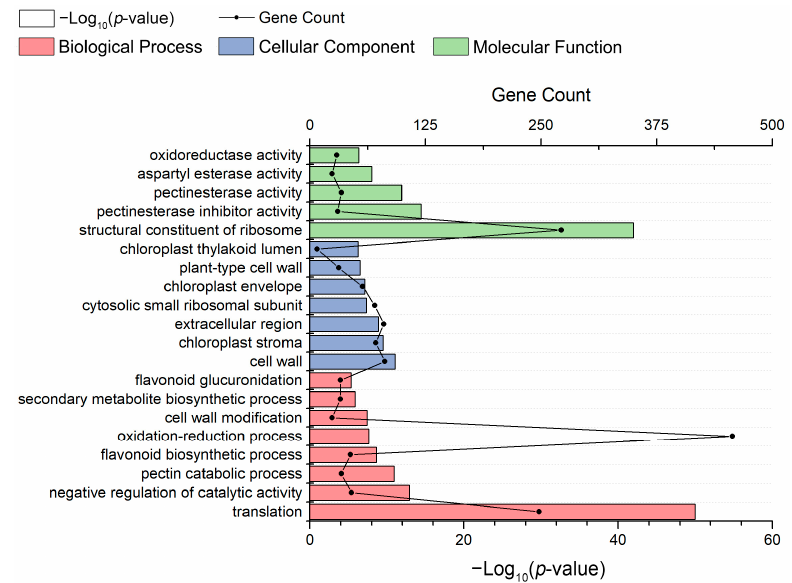
Figure 3. GO enrichment analysis of the top 20 most strongly represented categories. The names of the GO categories are listed along the y-axis. The degree of GO enrichment is represented by the − log 10 ( p -value) (column chart) and the number of transcripts (line chart) enriched in each category.